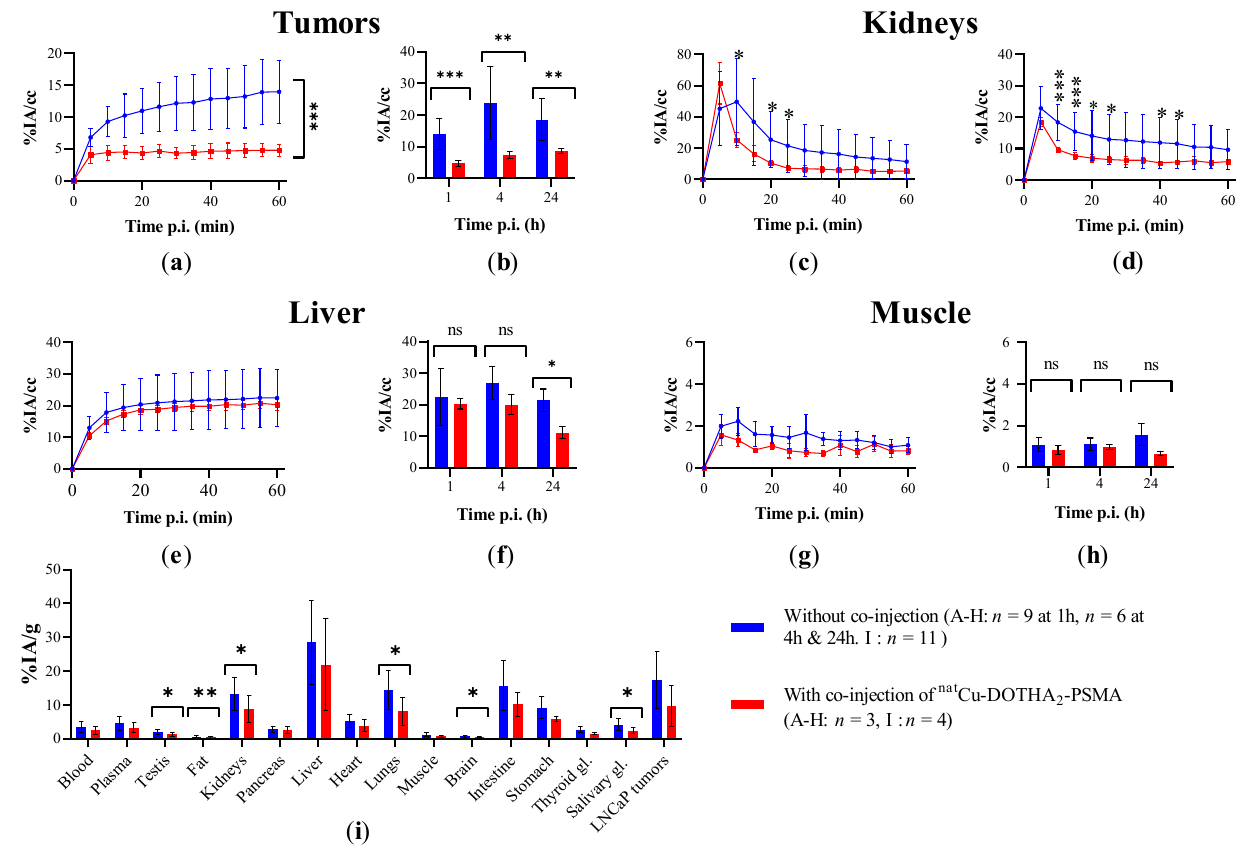
Figure 4. Time–activity curves and histograms in ( a , b ) tumor, in kidney ( c ) calyxes and ( d ) cortex, ( e , f ) liver, and ( g , h ) muscle for the PET imaging of NOD-Rag1 null IL2rg null (NRG) mice and ( i ) biodistribution following the last scan. Note the changes in the Y-axis for better visualization. For time–activity curves and biodistributions, only significant differences are shown for clarity. Ns: nonsignificant, *: p < 0.05, **: p <0.01, ***: p < 0.001.